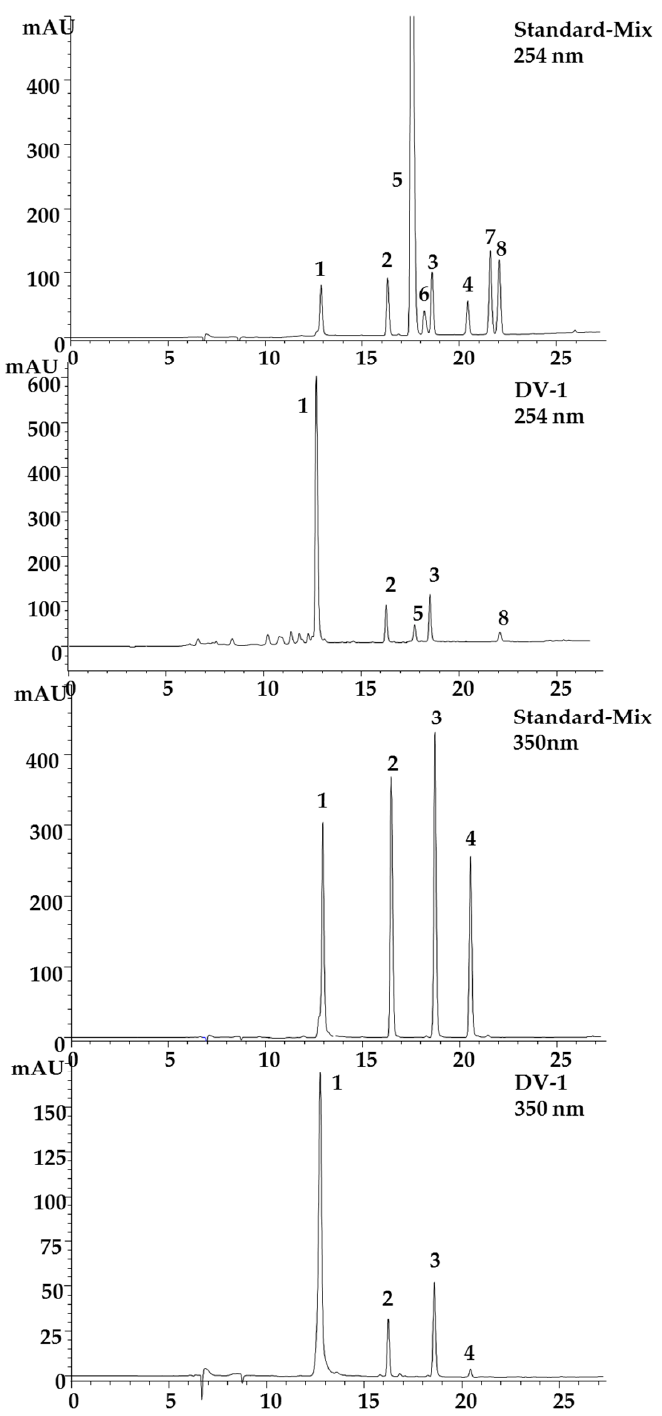
Figure 2. HPLC separation of all standards 1 to 8 at 254 nm and all coumarins 1 to 4 isolated from the marine green alga Dasycladus vermicularis at 350 nm, and the sample DV-1 from the marine green alga Dasycladus vermicularis at 254 nm and 350 nm under optimized conditions (column: Gemini C18, 110 Å column (150 × 4.6 mm, 3 µ m); mobile phase (A) aqueous 20 mM ammonium acetate solution with 1.5% acetic acid and (B) methanol/water (9:1) with 20 mM ammonium acetate and 1.5% acetic acid. Gradient: 2% B to 15% B from 0 to 5 min and 15% B to 60% B from 5–20 min and 60% B to 98% B from 20–25 min; detection at 254 nm and 350 nm, flow rate 0.3 mL/min, injection volume 5 μ L and 40 °C oven temperature. Peak assignment is according to Figure 1.